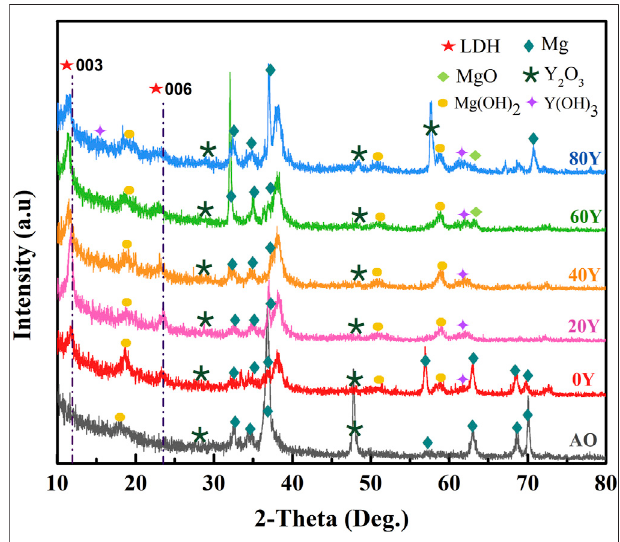
FIGURE 1 | XRD image of specimens with different Y% fabricated on anodized oxide fi lms on Mg – 2Zn – 4Y